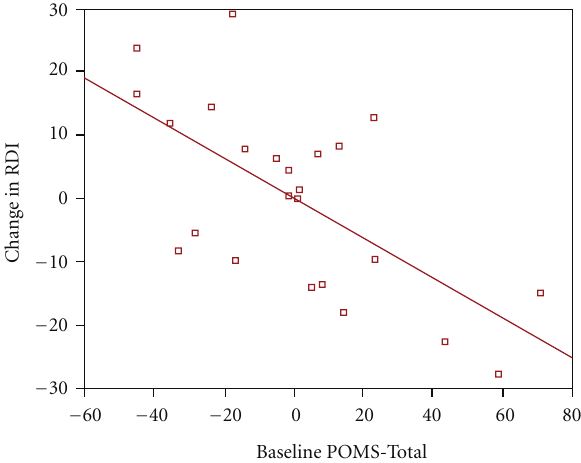
Figure 2: Partial regression plot of change in AHI versus baseline POMS-Total after controlling for baseline